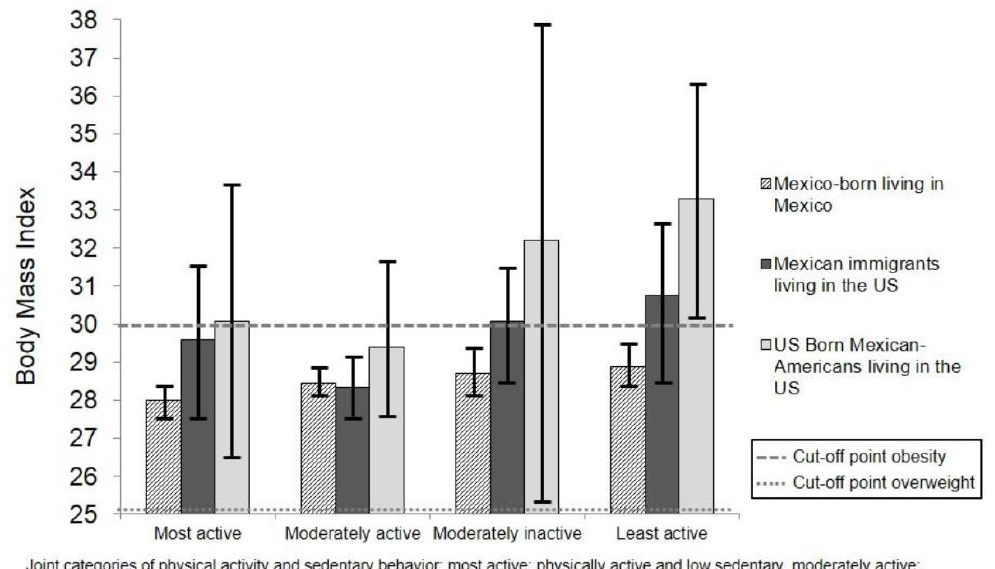
Figure 1. Mean of body mass index among Mexican-born living in Mexico and Mexican immigrants and Mexican-Americans living in the US according to joint categories of moderate-to-vigorous physical activity (MVPA) and sedentary behavior.